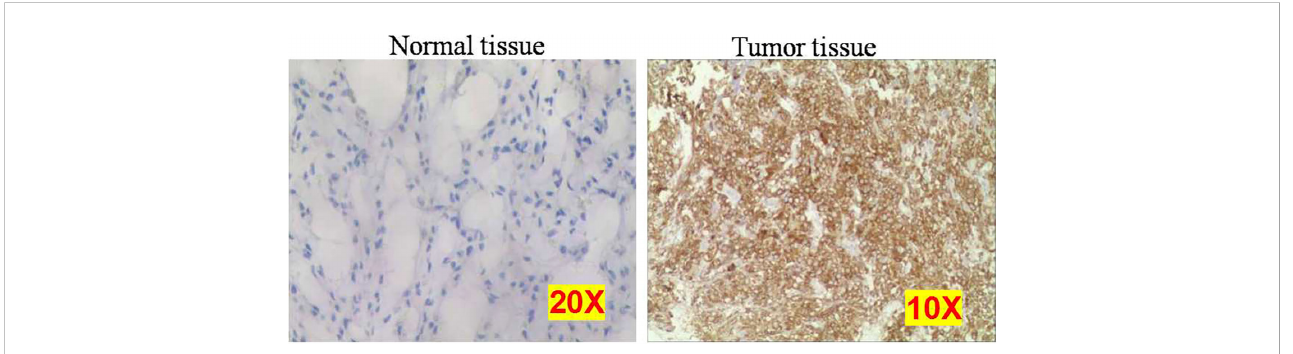
FIGURE 4 Representative images of normal and osteosarcoma tissues using immunohistochemistry. Each experiment was repeated for three times, and each group had four replicates.